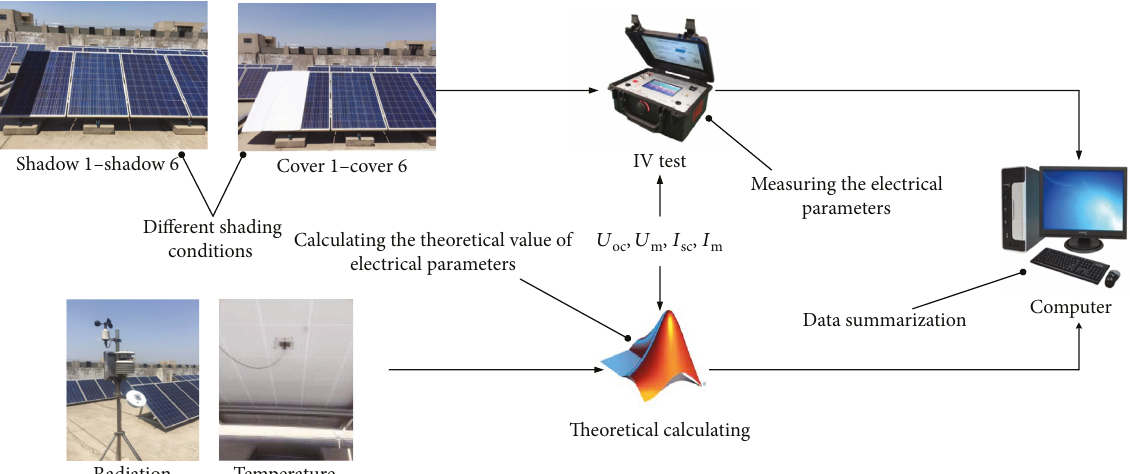
Figure 11: Block diagram for experimental testing. By comparing the theoretical value and the measured value, summarize the